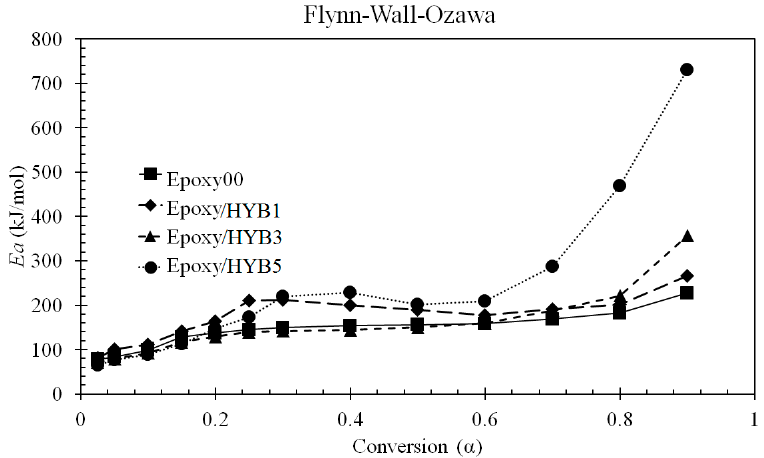
Figure 5. Comparison of Ea versus conversion corresponding to different filler loadings using the Flynn–Wall–Ozawa Flynn–Wall–Ozawa method.